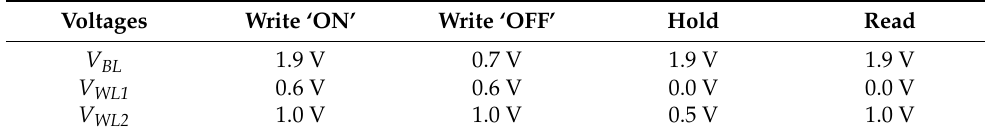
Table 2. The M3D − FBFET − SRAM cell operation voltages.